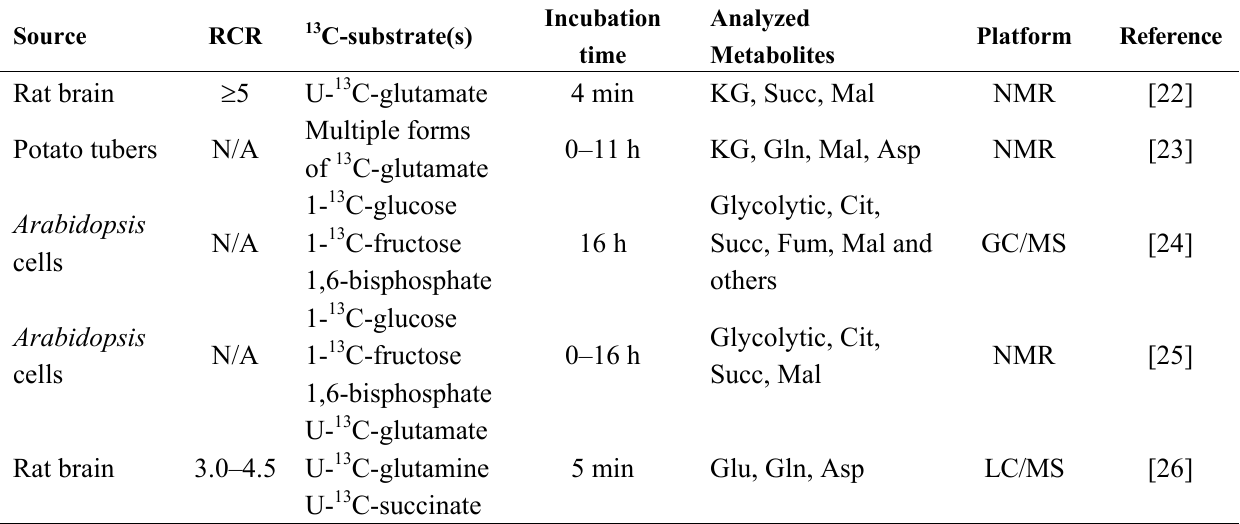
Table 1. Publications performing 13 C tracer analysis in isolated